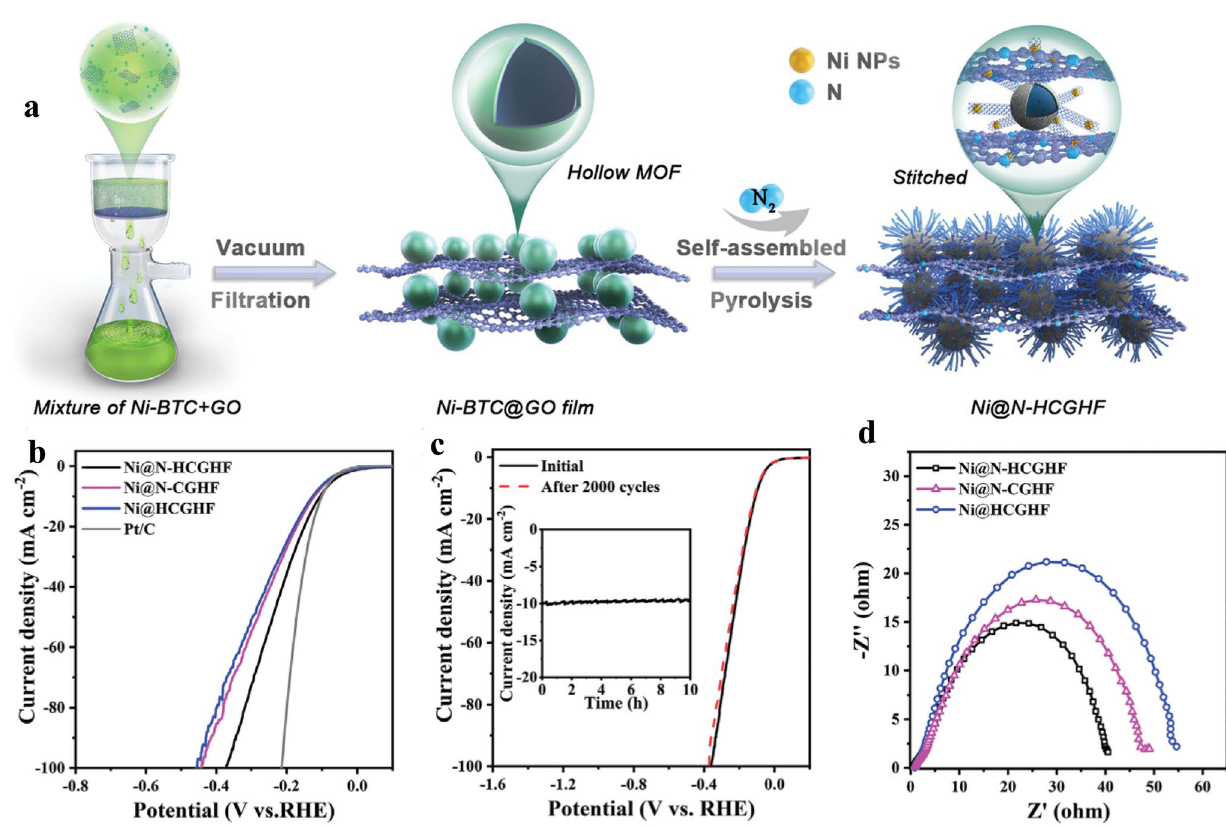
Fig. 11 a Schematic of the preparation of Ni@N-HCGHF, b LSV curves for HER of various samples. c LSV curves for HER of Ni@N- HCGHF before and after 2000 CV cycles (inset: the current–time curve of Ni@N-HCGHF). d EIS Nyquist plots [30], Copyright © 2020, John Wiley and